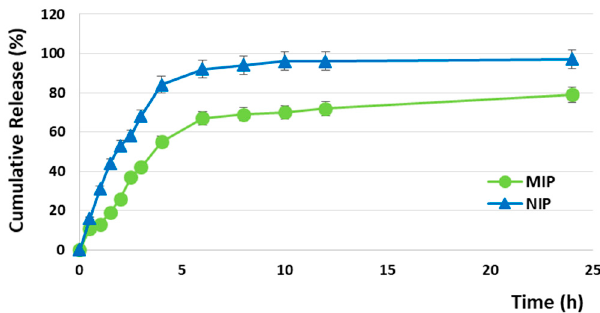
Table 6. Drug loading content (DLC) and drug loading efficiency (DLE). Drug Loading Content (DLC)